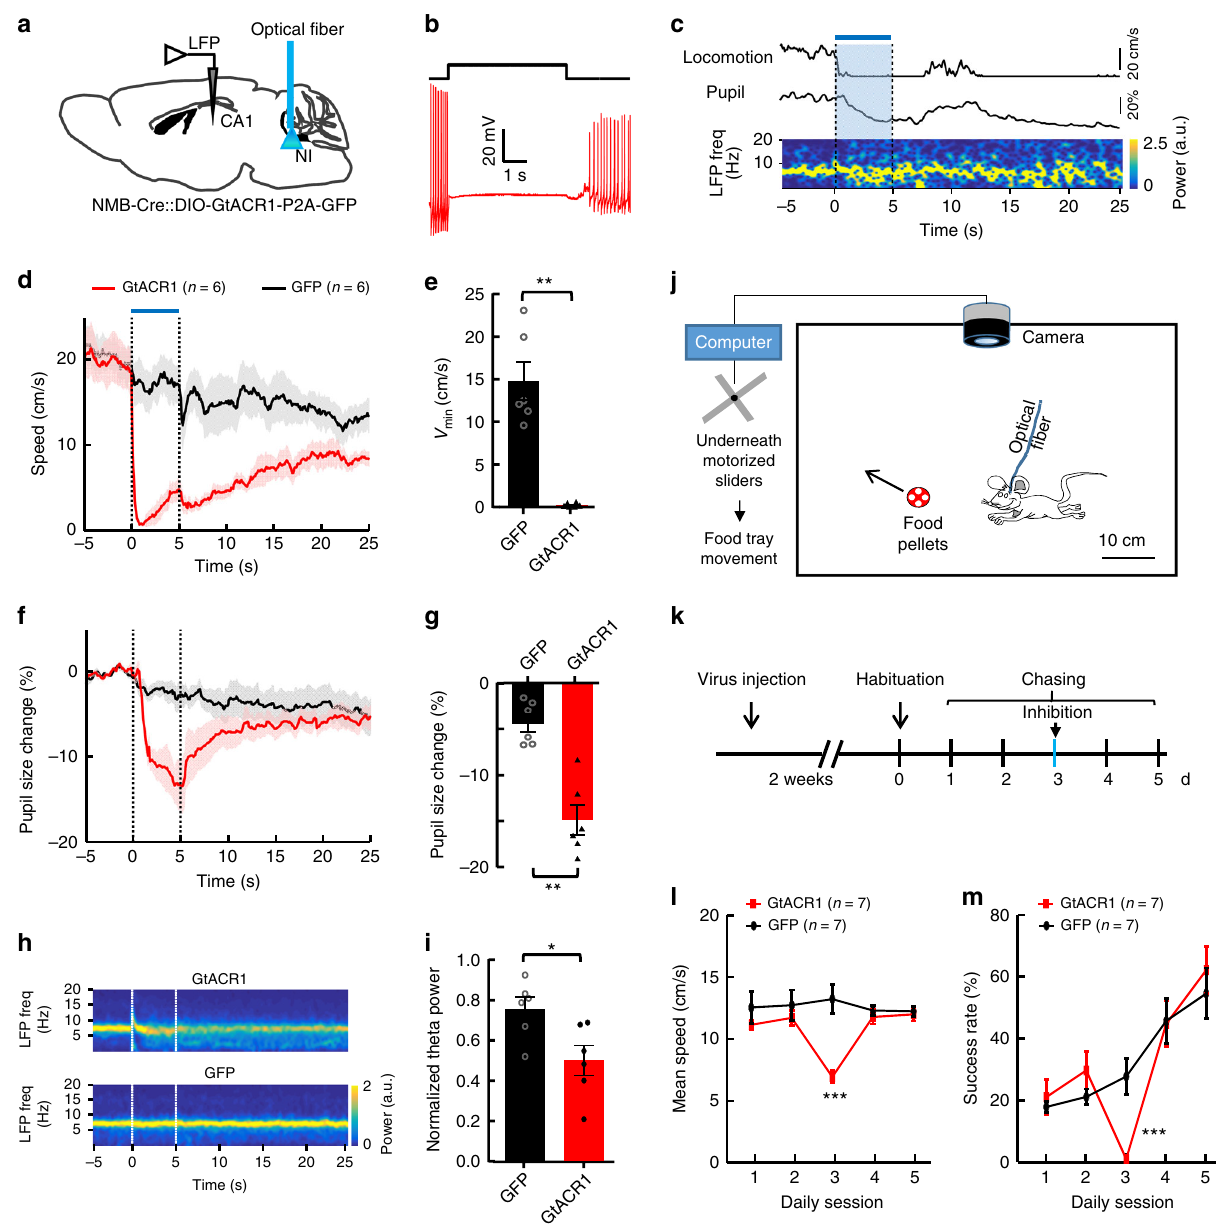
Fig. 2 Inhibiting NI NMB neurons suppresses locomotion, arousal, and theta power. a Experimental schematic for inhibiting NI NMB neurons and recording hippocampal LFP in head- fi xed mice. b A blue laser pulse (5s) abolished action potential fi ring elicited by current injection into a GtACR1-expressing neuron in the NI ( n = 7 cells tested). c Raw traces showing the effect of optogenetic inhibition (blue bar) of NI NMB neurons on locomotion, arousal, and theta rhythms. d Locomotor speed aligned to laser onset. e Bar plot showing the inhibition effects on locomotor speed ( n = 6 mice for all groups). f , g The effect of optogenetic inhibition on the pupil diameter across time ( f ) and summary data ( g ). h , i Grand mean of hippocampal LFP spectrograms aligned to laser onset ( h ) and summary data of optogenetic inhibition on theta power normalized to the sum of 0.1 – 12Hz power ( i ). j , k Schematic ( j ) and time line ( k ) illustrating the food-chasing task, in which a mouse chased after a moving food tray to retrieve food pellets. In the third behavioral session we optogenetically inhibited NI neurons ( k ). l , m Optogenetic inhibition of NI neurons suppressed the chasing speed ( l ) and aborted the success rate of reaching the moving food tray ( m ). Shaded areas ( d , f ) and error bars ( e , g , i , l , m ) indicate SEM. * P <0.05, ** P <0.01, *** P < 0.001; unpaired t test; see Supplementary Table 1 for detailed statistical analysis. Source data are provided as a Source Data fi